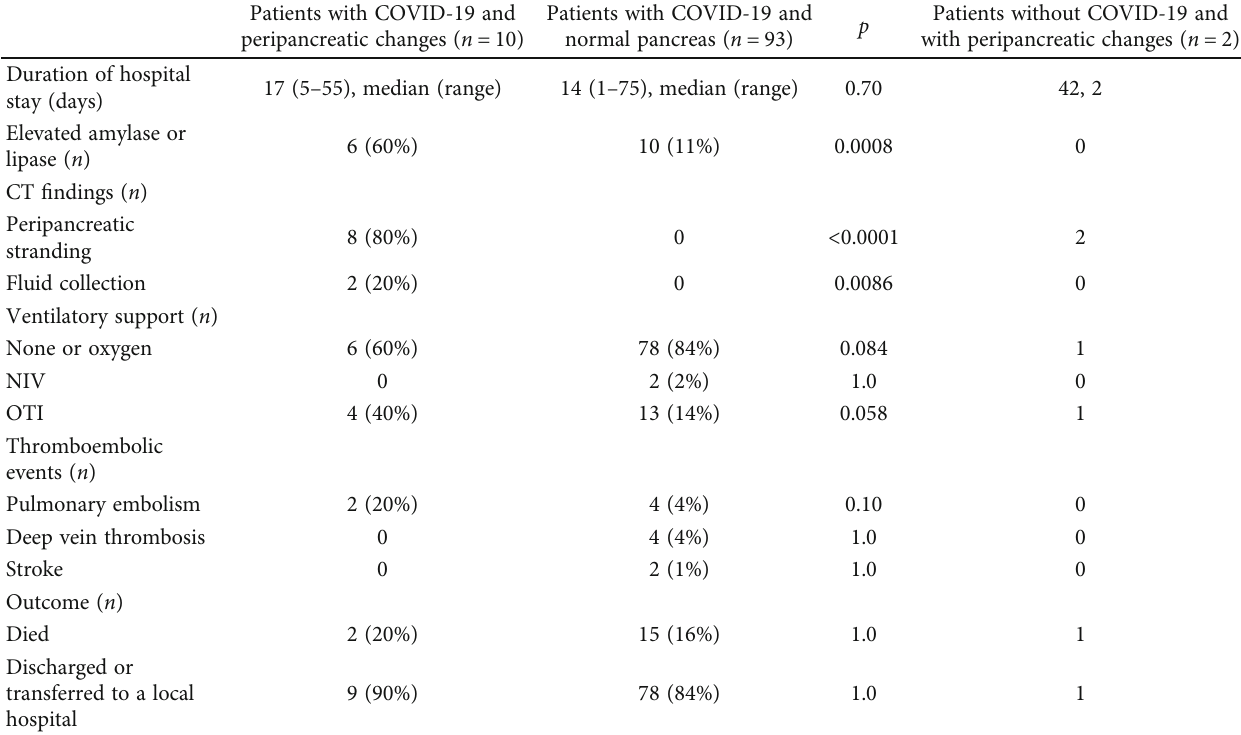
Table 2: Clinical data from the hospital stay. Patients with COVID-19